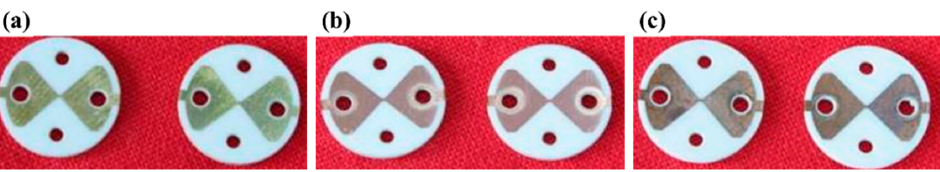
Figure 6. The photographs of ( a ) Sample A, ( b ) Sample B, and ( c ) Sample C with a 5-mm diameter.